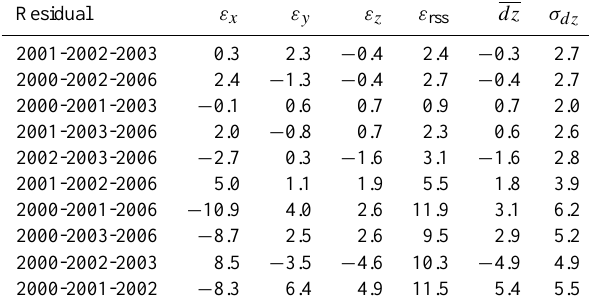
Table 3. The universal co-registration vector residuals and the RSS (Root Sum of Squares) of the total vector mean and standard devia- tions of the elevation change residuals as solved through triangula- tion of three DEMs. dz and σ dz are the mean and standard deviation of the triple vertical difference in the DEMs. These estimates rep- resent an internal coherency between the three datasets that reflect the residual shift resulting from uncertainties in the solution of the universal co-registration